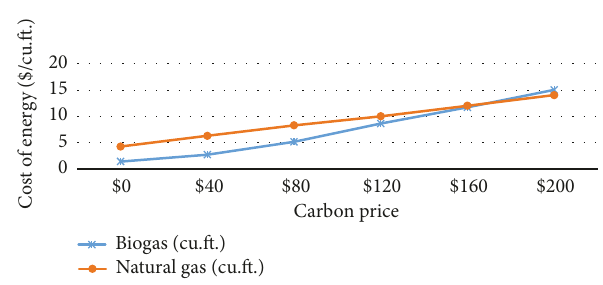
Figure 7: Impact of carbon price on energy cost using biogas and natural gas.